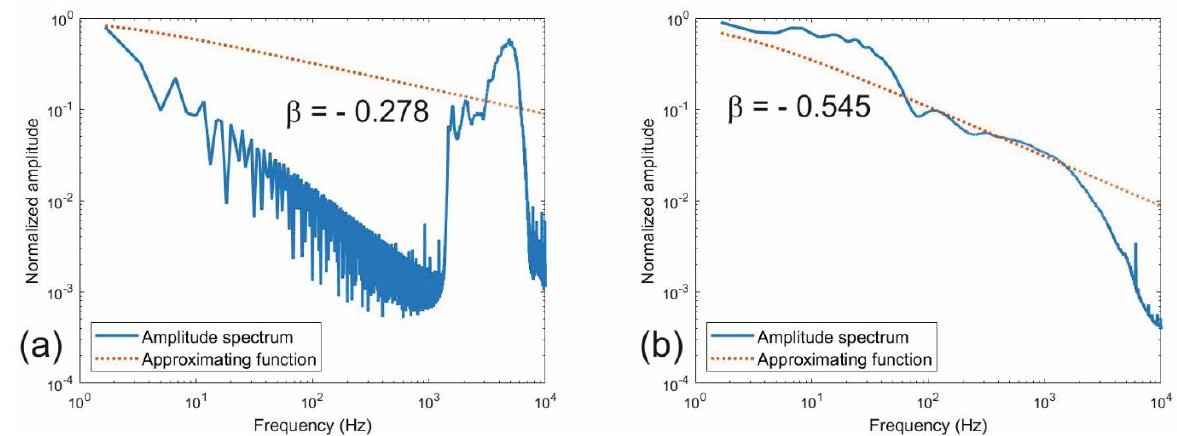
Figure 2. Normalized amplitude spectra of Chirp data before ( a ) and after ( b ) the envelope operator (continuous blue lines) plotted in a logarithmic scale. The approximating function | ω | β is represented by the dotted orange line. Notice the different values in the two cases and the closer match for the enveloped Chirp data ( b ).